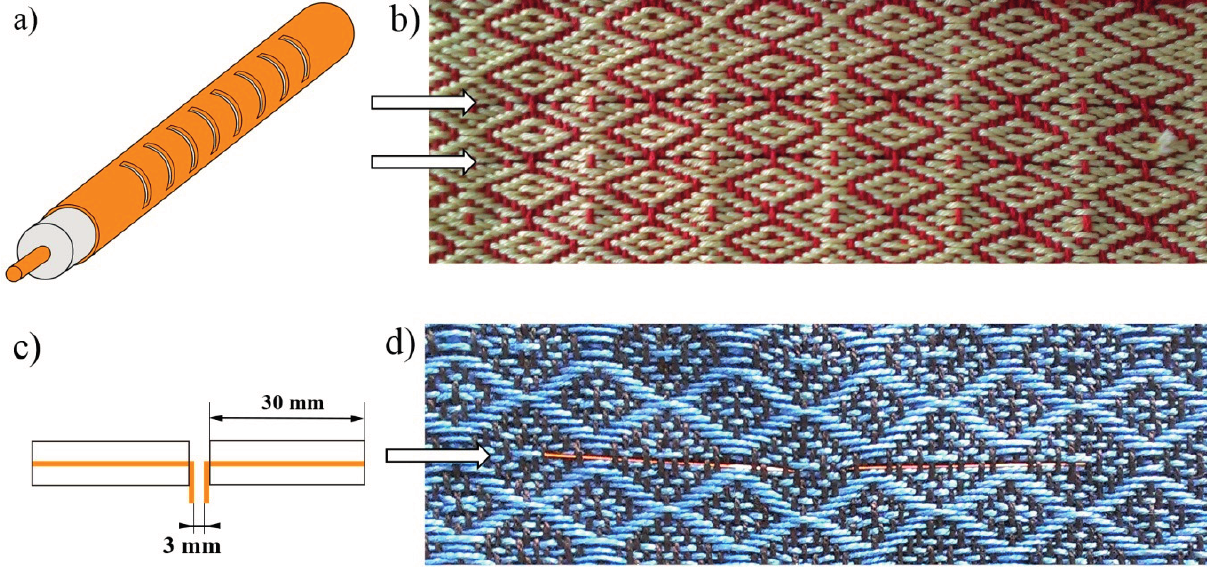
Figure 5. LCX ( a ) and dipole; ( b ) and cotton; ( c ) antennas (arrowed) weaved into the threads of a wool; ( d ) textile fabric. Both antennas were fabricated using polymer coated hollow-core silica glass fibers with an inner radius of 100 μ m and outer radius of 181 μ